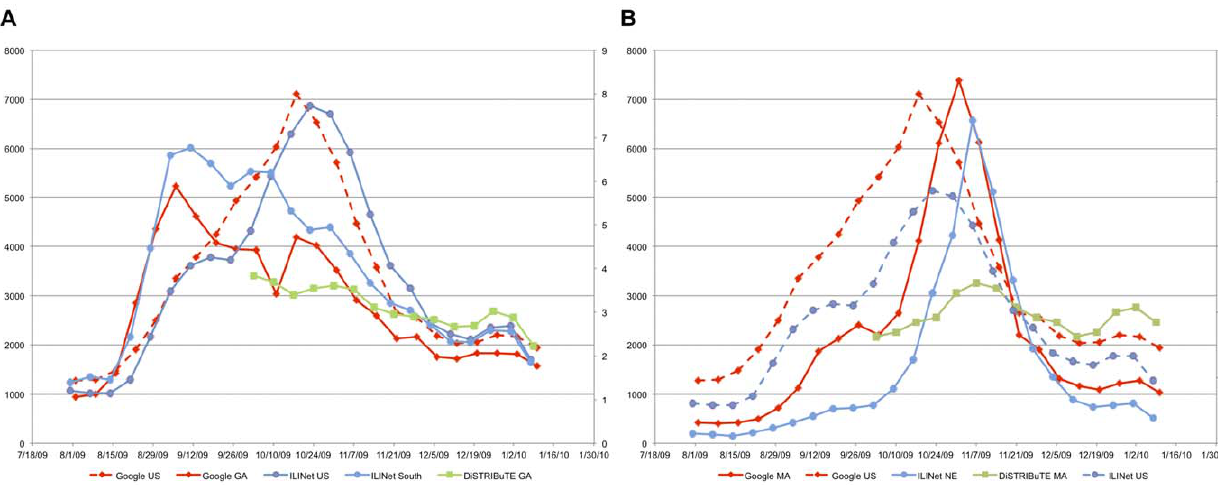
Figure 6. Influenza-like illness surveillance for the Northeast, South and entire United States. Panel A. Percentage of visits for influenza- like illness (ILINet), U.S. and South, July 31, 2009–January 8, 2010; Google Flu Trends index, U.S. and Georgia (GA), August 2, 2009–January 10, 2010; scaled DiSTRIBuTE ILI trends, Georgia (GA), October 3, 2009–January 9, 2010. Panel B. Percentage of visits for influenza-like illness (ILINet), U.S. and Northeast (NE), July 31, 2009–January 8, 2010; Google Flu Trends index, U.S. and Massachusetts (MA), August 2, 2009–January 10, 2010; scaled DiSTRIBuTE ILI trends, Massachusetts (MA), October 3, 2009–January 9, 2010. Sources: author’s calculations based on CDC, Google, and DiSTRIBuTE data available from: http://www.cdc.gov/h1n1flu/cdcresponse.htm, http://www.google.org/flutrends/, and